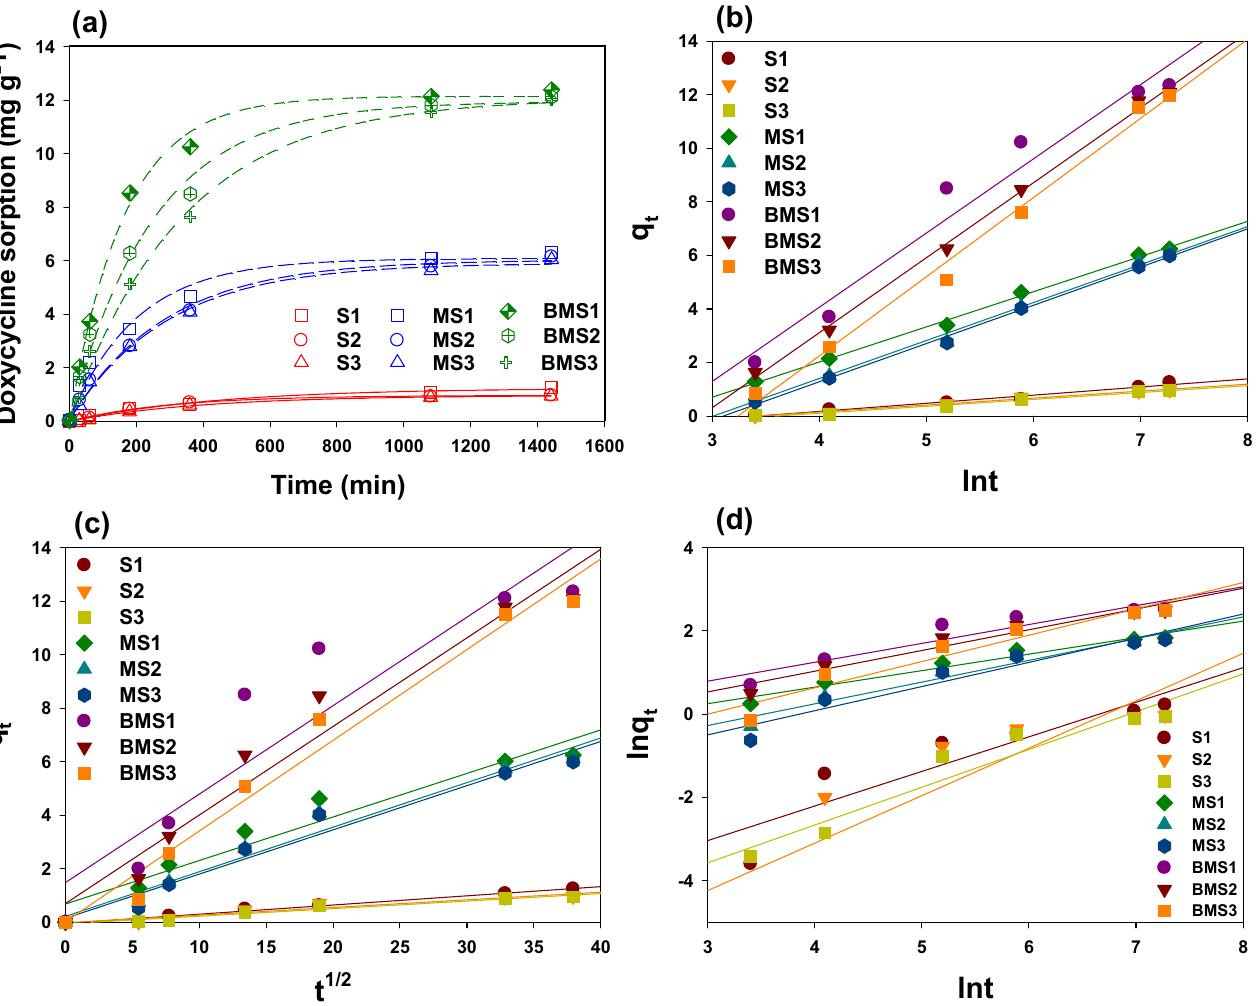
Figure 4. ( a ) Doxycycline sorption kinetics onto different soils (pH 7.41 (S1), pH 8.32 (S2), and pH 8.48 (S3)), manure + S1 (MS1), manure + S2 (MS2), manure + S3 (MS3), mesquite wood-waste-derived biochar + MS1 (BMS1), mesquite wood-waste-derived biochar + MS2 (BMS2), and mesquite wood-waste-derived biochar + MS3 (BMS3), as well as Elovich ( b ), intraparticle diffusion ( c ), and power function ( d ) plots of kinetics model fittings.